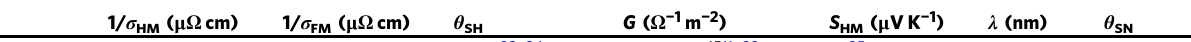
Table 1 Parameters for analysis of transverse spin Nernst